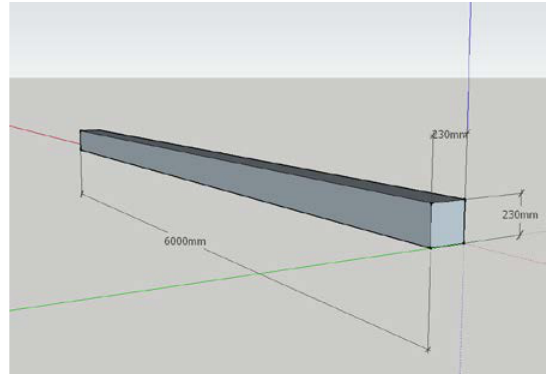
Figure 7. 3D Model for 230mm x 230 mm x 6000 mm Table 2 shows the dimensional measurement difference between, measuring tape and Revit model. Meanwhile, the analysis for this study included the comparison of measurement between Revit model and conventional method (measuring tape) with the base model from the architecture. The comparison was done and recorded in Table 3. The RMSE value of the base model with point cloud data was 2.972mm while base model with conventional method was 13.687mm.